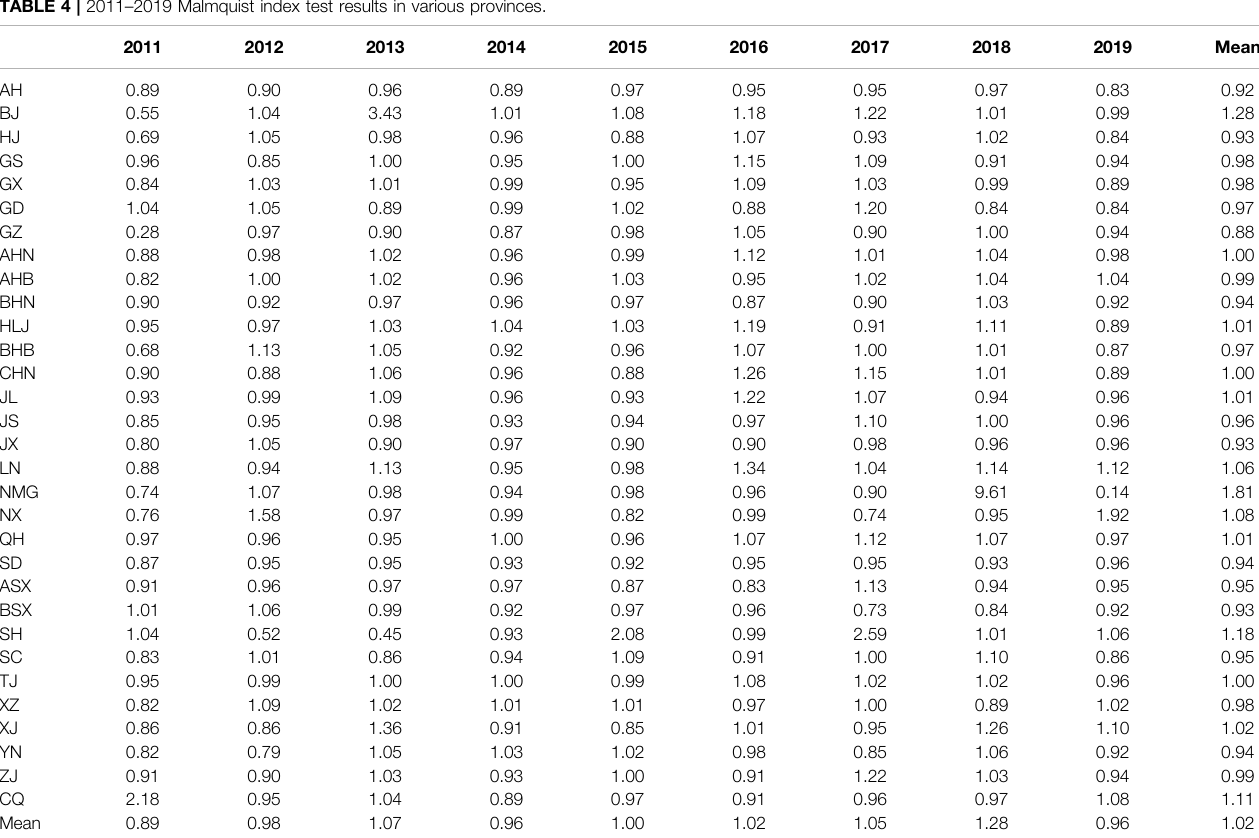
TABLE 4 | 2011 – 2019 Malmquist index test results in various